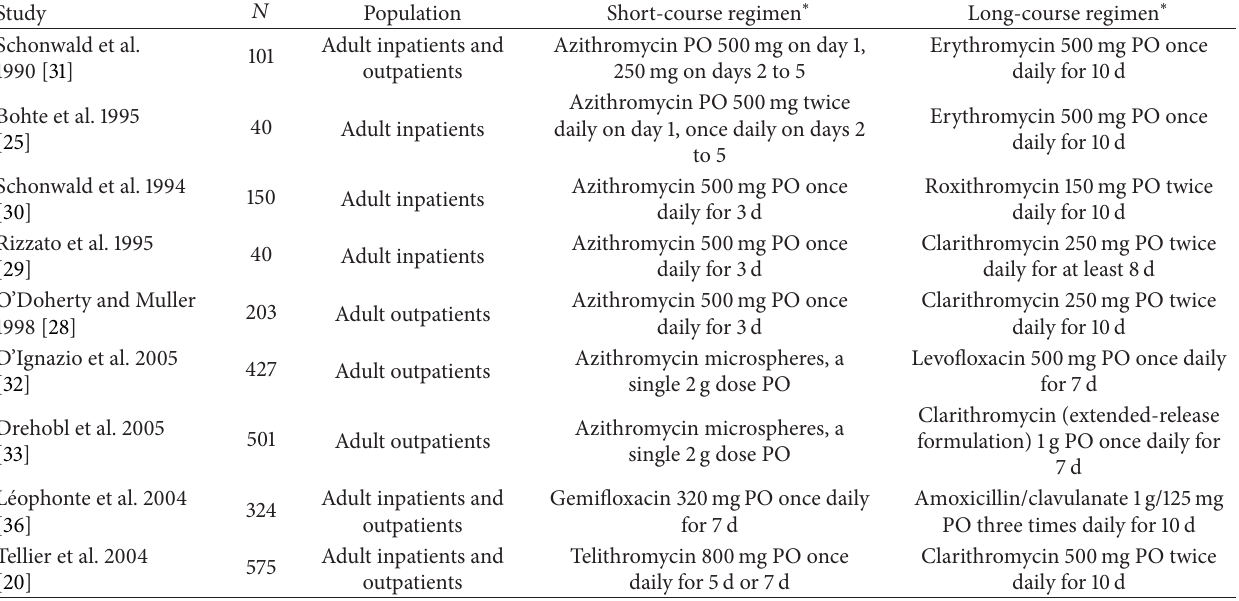
Table 3: Studies comparing the efficacy of short-course versus long-course antibiotic regimens for the treatment of CAP, using different antimicrobial